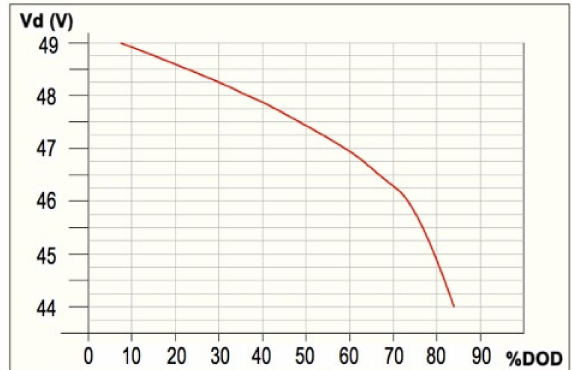
Figure 9. Battery bank voltage measured in discharge and corresponding